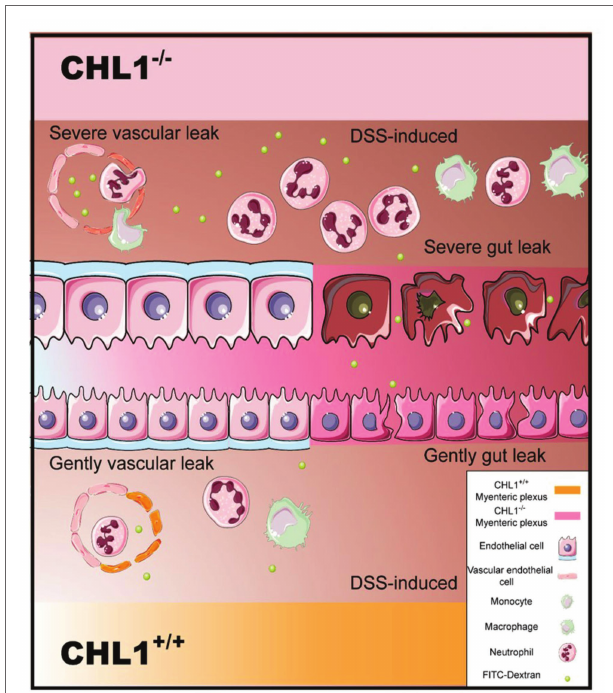
FIGURE 5 | Model of CHL1 deficiency-mediated exacerbation in mouse colitis. The loss of CHL1 exacerbates DSS-induced intestinal inflammation and immune responses in mice. Lamina propria is edematous. Inflammation cells, such as neutrophils and macrophages, infiltrate epithelial layer cell. CHL1 deficiency damages intestinal epithelial cells, and leads to the injury of epithelial barrier function. Furthermore, FITC cross the epithelial barrier after DSS exposure in CHL1 −/−